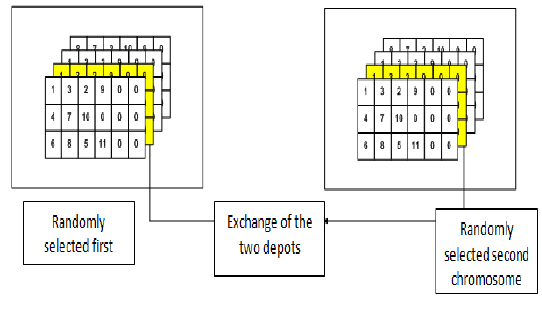
Figure 2: Crossover operator developed for CPP in GA.